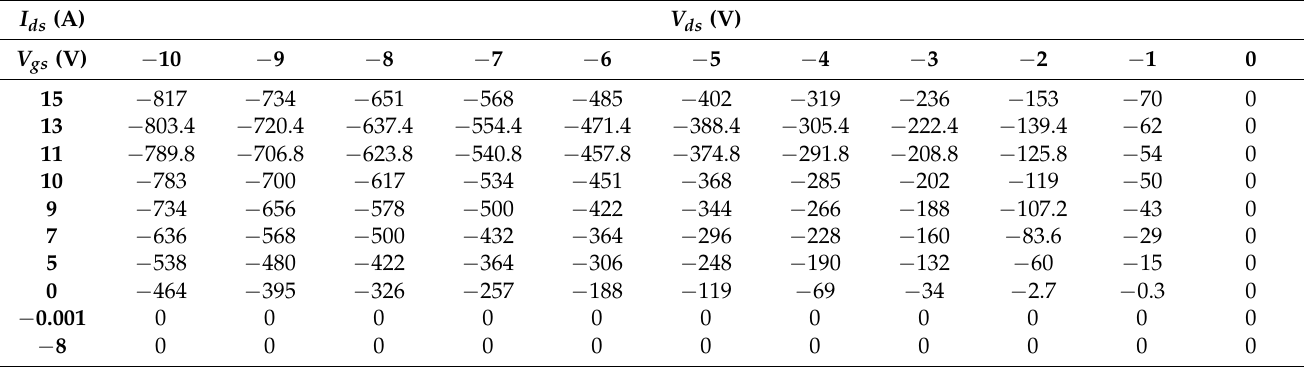
Table 3. Third quadrant SiC MOSFET I ds current with respect to the V gs & V ds voltages at 25 ◦ C.